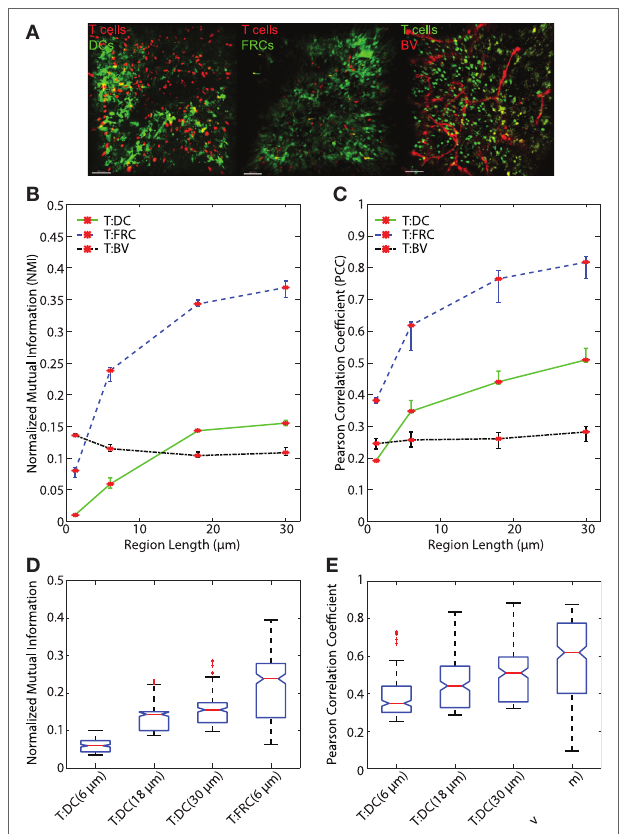
FigUre 5 | (a) Sample images of T:DC (T cells labeled in red and DCs labeled in green), T:FRC (T cells labeled in red and FRCs labeled in green), and T:BV (T cells labeled in green and blood vessel labeled in red). (B,c) Line plots representing the NMI (B) and PCC (c) of T cells and DCs (T:DC, green line), T cells and FRCs (T:FRC, blue dashed line), and T cells and blood vessel (T:BV, black dotted line). NMI and PCC were calculated on pixels (region length = 1.2 μ m), or regionalized images of increasing side length (6, 18, and 30 μ m). Red stars indicate medians for the corresponding region size, and error bars indicate the 95% confidence interval around the median (40). For